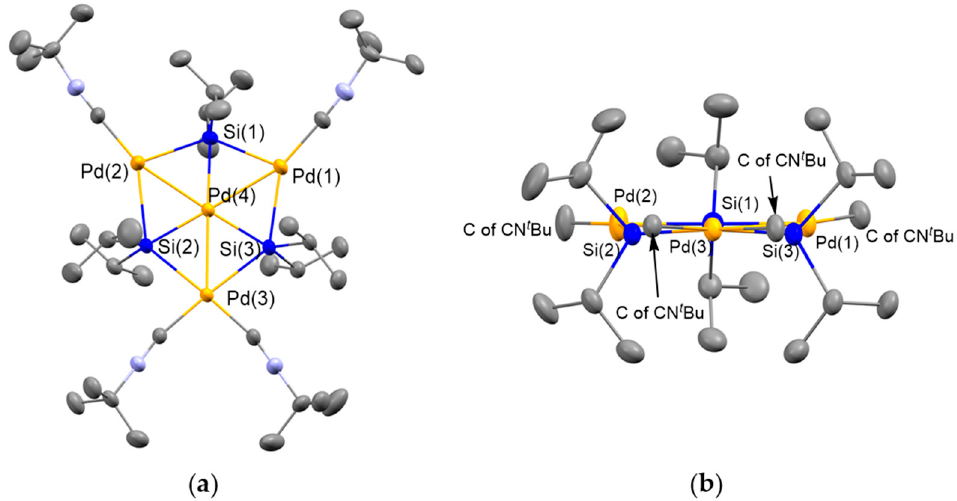
Figure 1. ( a ) Top view of the molecular structure of 4 with 50% probability ellipsoids. Hydrogen atoms were omitted for clarity; ( b ) Side view of 4 . All atoms derived from the isocyanide ligands except for the coordinated carbon atoms, and all hydrogen atoms were omitted for clarity.